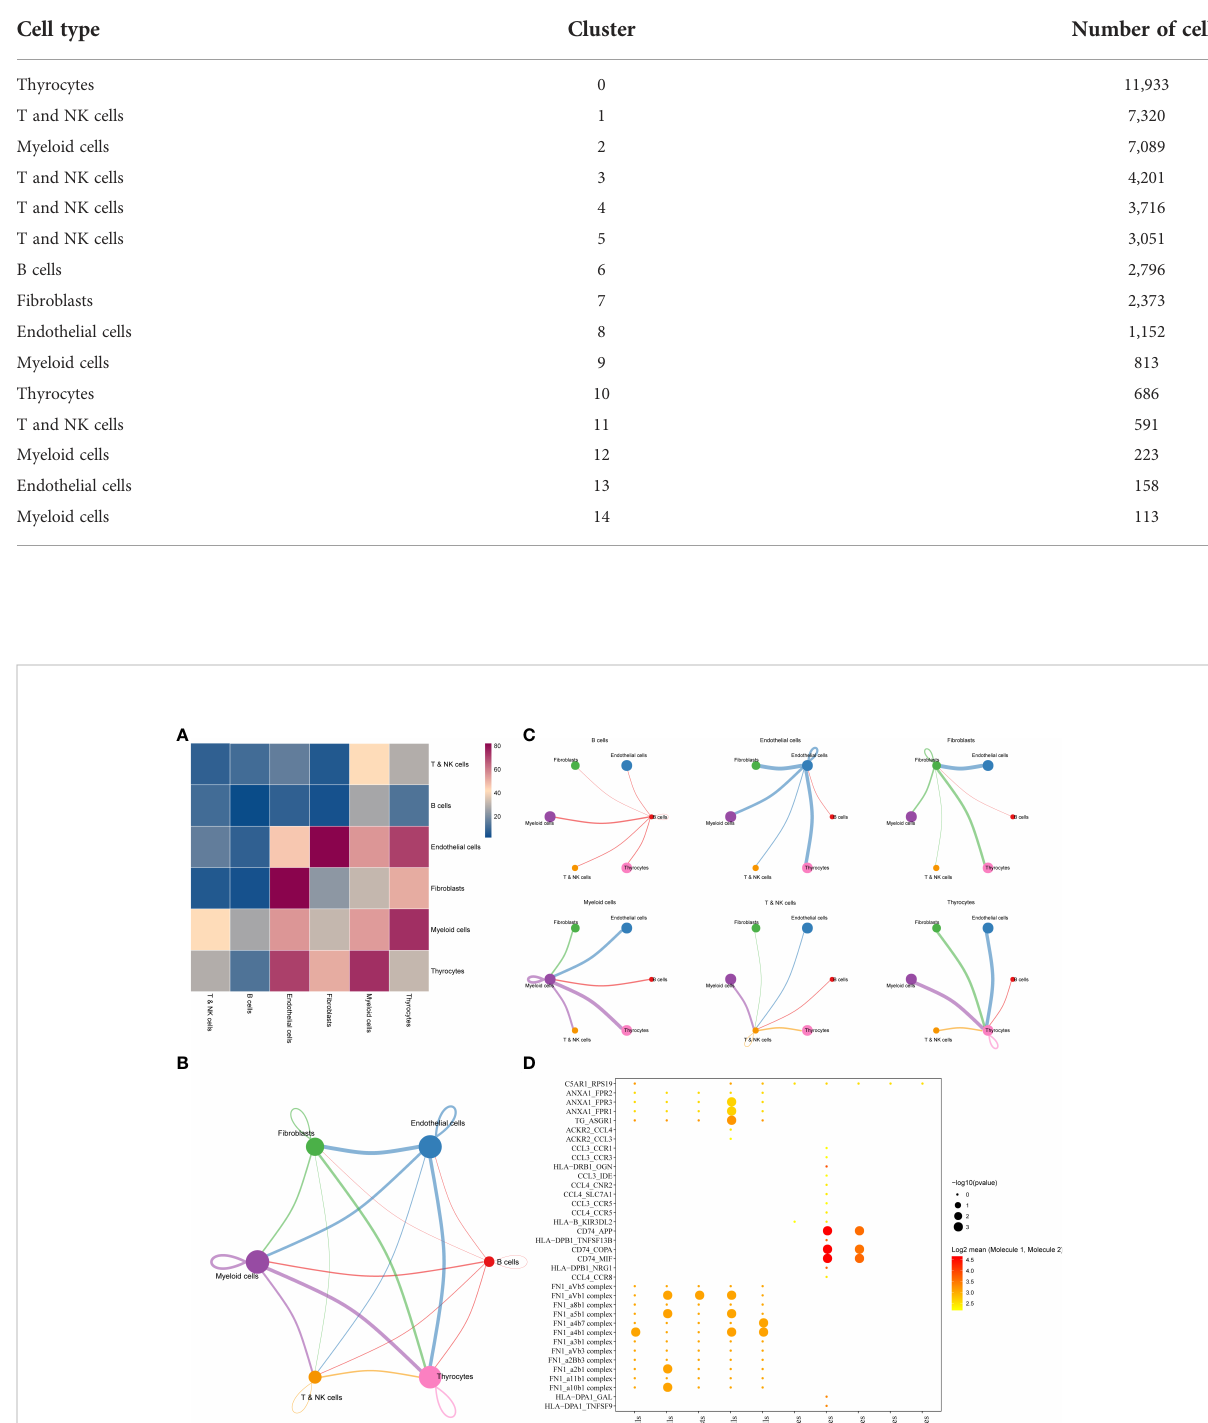
TABLE 3 Cell type annotation for 14 cell